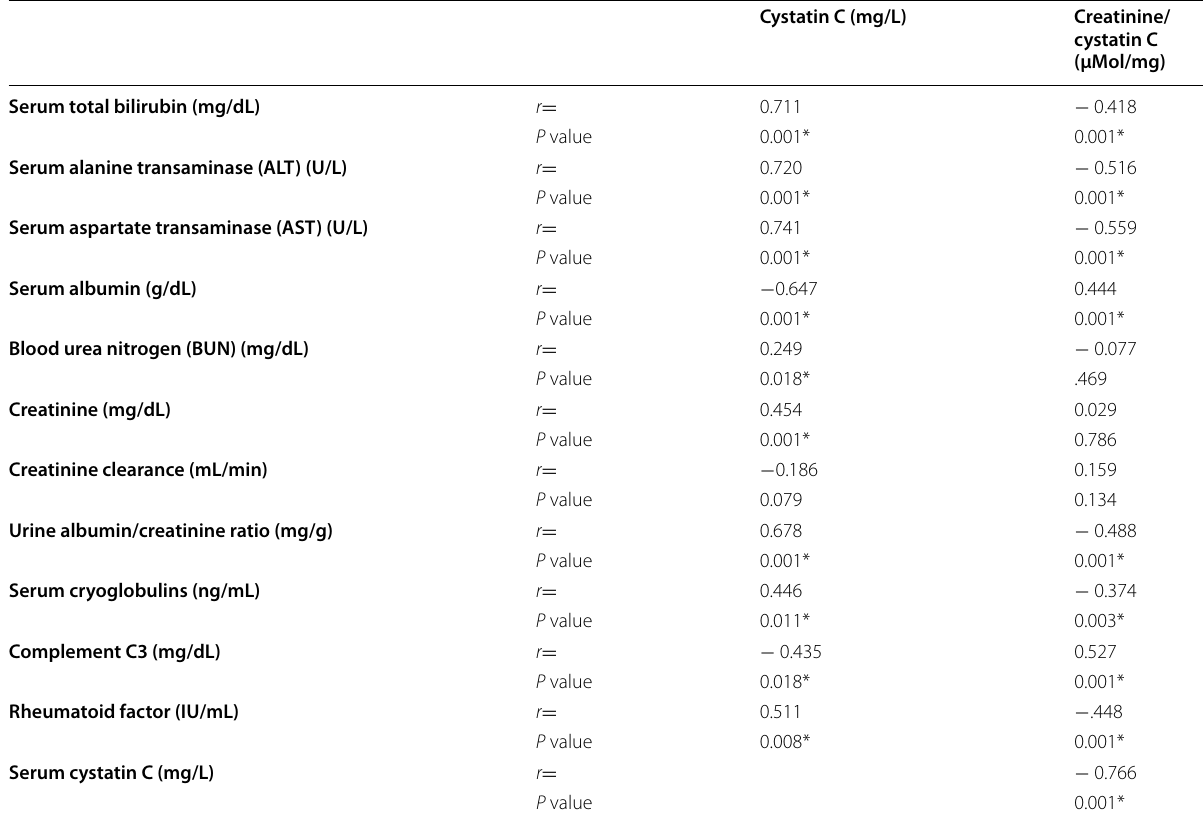
Table 3 Correlation between